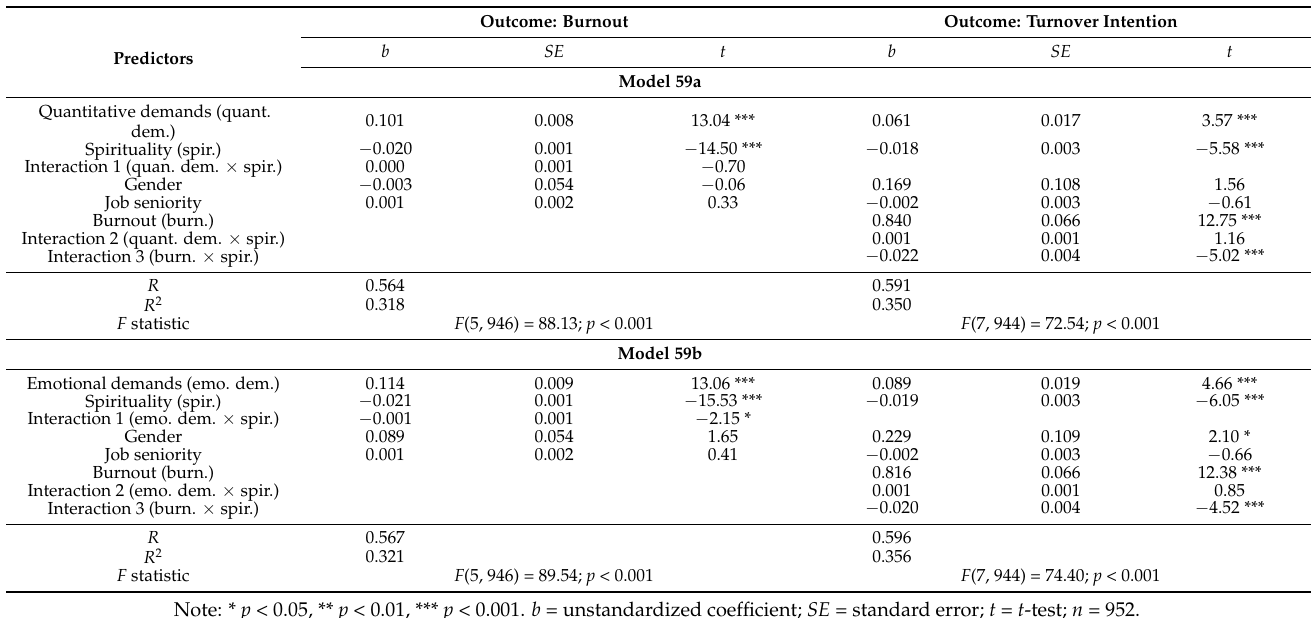
Table 3. Moderated mediation analyses when using spirituality at work as a moderator.